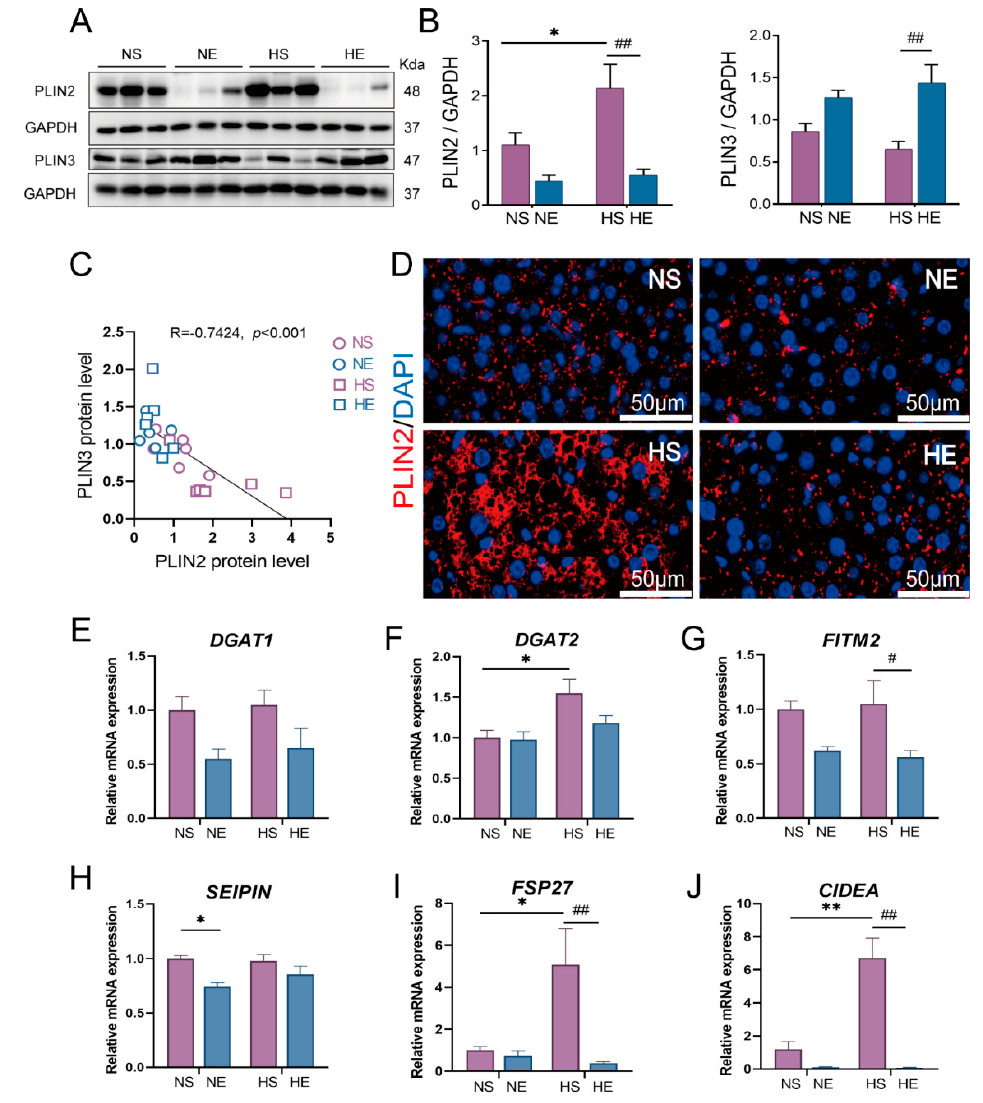
Figure 4. Exercise inhibits LD biogenesis by preventing LD expansion. ( A , B ) Representative of LD membrane protein PLIN2 and PLIN3 immunoblotting and quantified data, ( C ) analysis of the cor- relation between protein levels of PLIN2 and PLIN3 ( n = 6), ( D ) representative immunofluorescence of PLIN2 in liver tissue (scar bar: 50 um, n = 3), ( E – J ) expression of LD biogenesis gene for DGAT1, DGAT2, FITM2, SEIPIN, CIDEA, and CIDEC were measured. Gene GAPDH was used as an internal reference gene ( n = 5). The data are expressed as mean ± SEM. * p < 0.05, ** p < 0.01 versus NS mice; # p < 0.05, ## p < 0.01 versus HS mice. In order to investigate the mechanism that exercise regulated hepatic LDs biogenesis, the expression levels of genes involved in controlling triglycerides synthesis, LD growth and budding, and LD expansion, including DGAT1, DGAT2, FITM2, SEIPIN, CIDEA, and FSP27, were examined (Figure 4D). The results showed that the expression of triglyceride synthesis enzyme DGAT2 and LD fusion genes, such as FSP27 and CIDEA, was signifi- cantly increased in the liver of HFD mice. On the contrary, exercise markedly decreased the mRNA expressions of FITM2, FSP27, and CIDEA in HFD mice. These results sug- gested that exercise might regulate LDs quality by inhibiting LDs expansion instead of the TG synthesis.